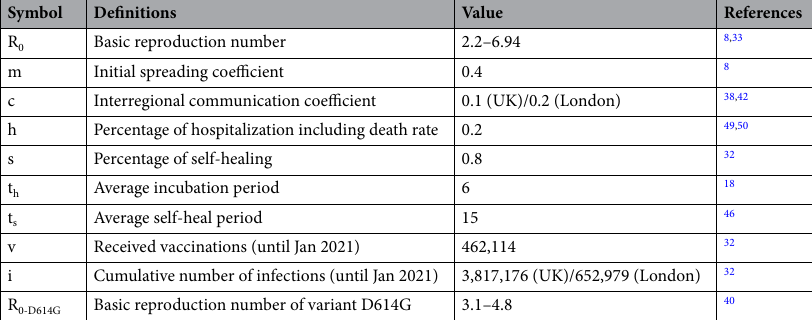
Table 1. Parameter symbols, definitions and values used as initial conditions in this study.